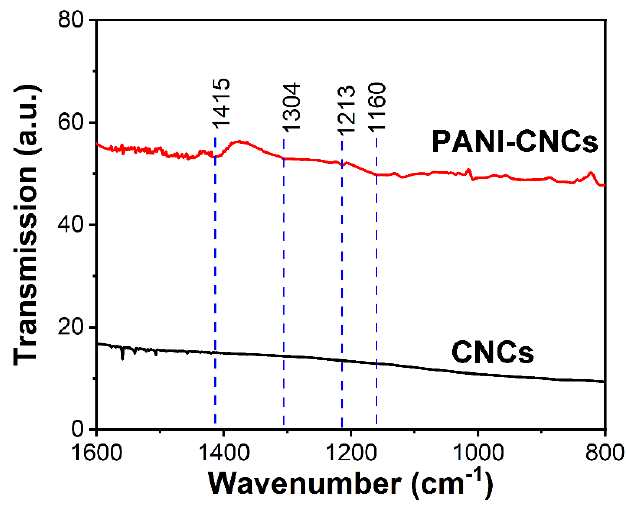
Figure 8. ATR-IR spectra for the bare CNCs and the 3-PANI-CNCs.